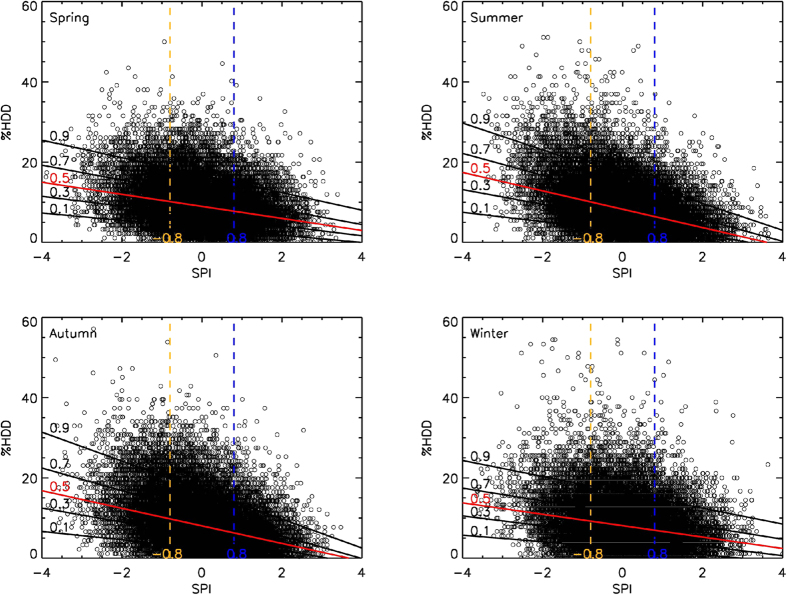
Quantiles analysis.Scatter plots of seasonal %HDD and SPI for all stations in China from 1971–2013. %HDD and SPI values from all stations during 1971–2013 were included in the quantile regressions. Quantiles selected as regression lines are 0.1, 0.3, median (0.5, red line), 0.7, and 0.9, respectively. Dry conditions were defined as SPI < −0.8 (yellow lines), and wet conditions were defined as SPI > 0.8 (blue lines). The map was generated with IDL 8.1.